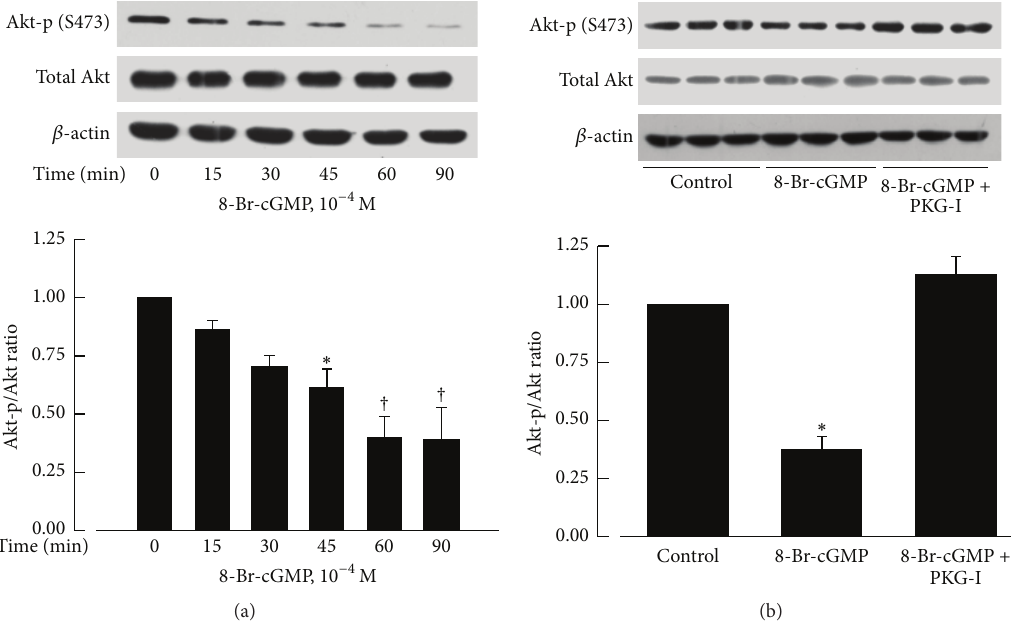
Figure 3: Effects of 8-Br-cGMP on protein levels of Akt-p (S473) and total Akt. Akt-p (S473) level was significantly reduced after 8-Br-cGMP (10 −4 M) treatment for 45 min (a) and this effect could be prevented by Rp-8-Br-PET-cGMPS (PKG-I, 3 × 10 −5 M; (b)). The upper panels are western blots. The lower panels are the summaries of densitometric scanning of proteins expressed as ratio of Akt-p (S473) to total Akt. Data shown as means ± SEM; 𝑛 = 6 for each group. ∗ significantly different from the control group ( 𝑃 < 0.05 ); † significantly different from the control group ( 𝑃 < 0.01 ).